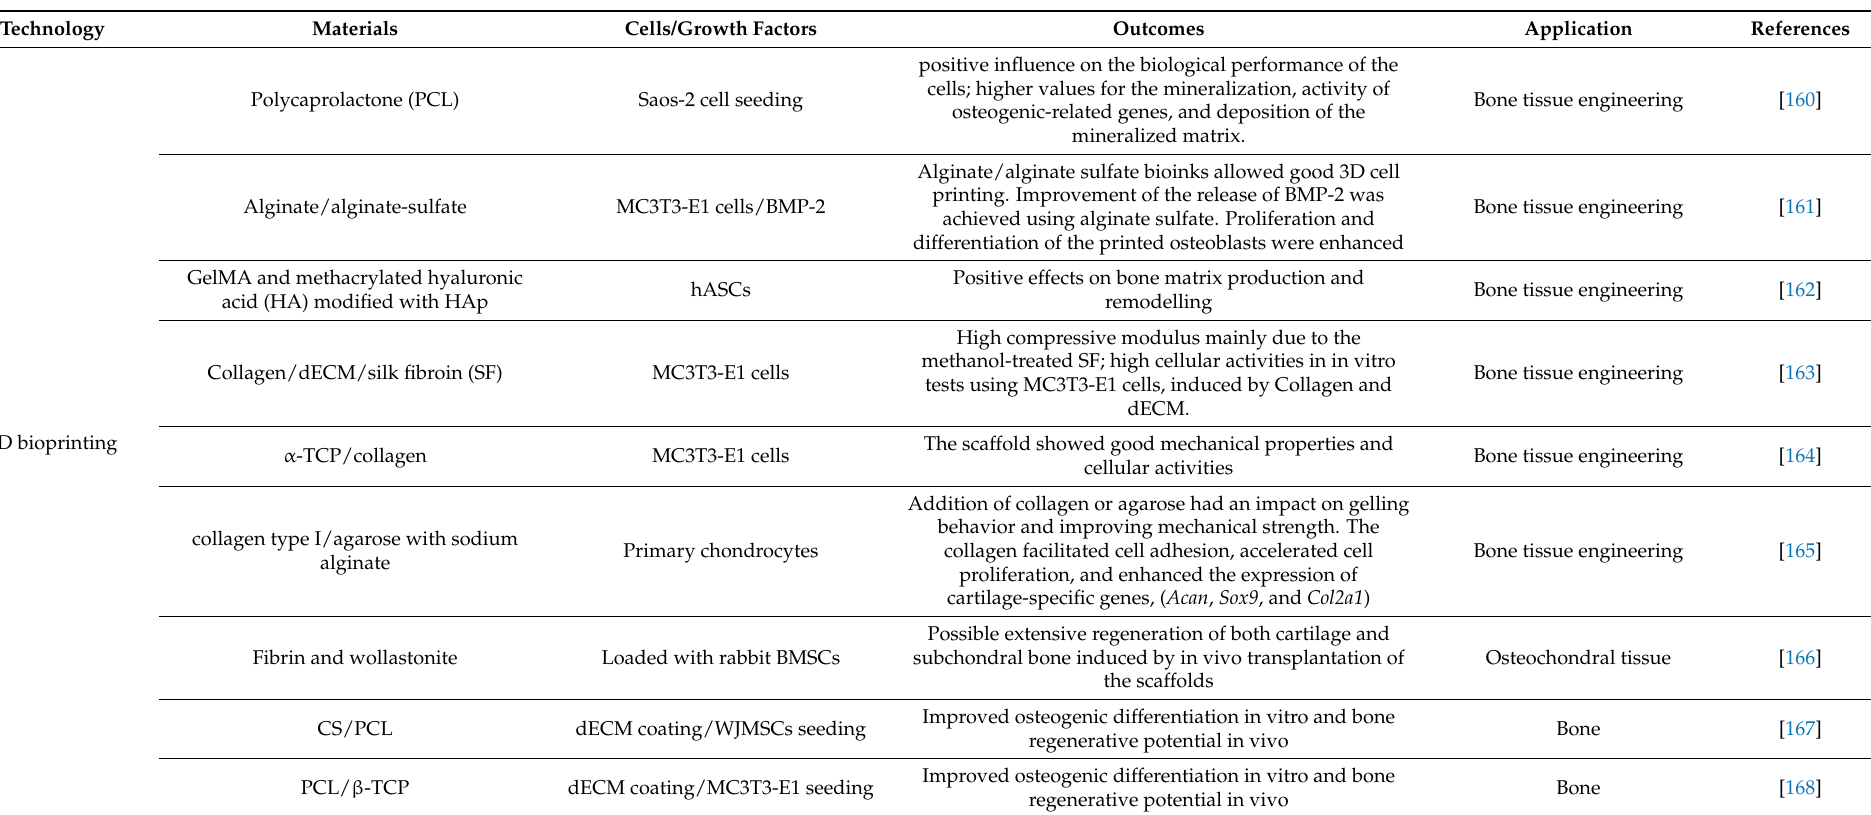
Table 4. Recent studies using different scaffold